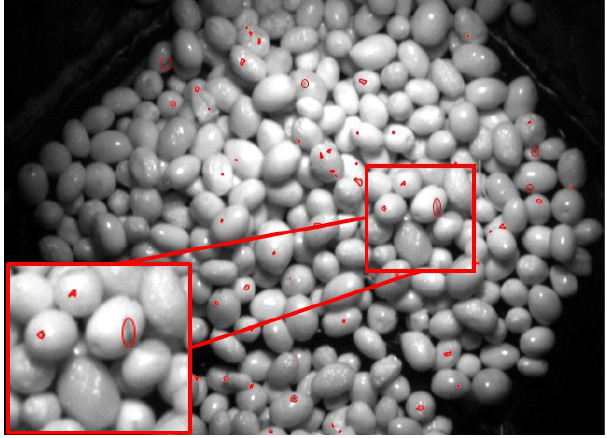
Figure 10. Example of ground-truth (including a zoom view) for the evaluation of the Image Processing